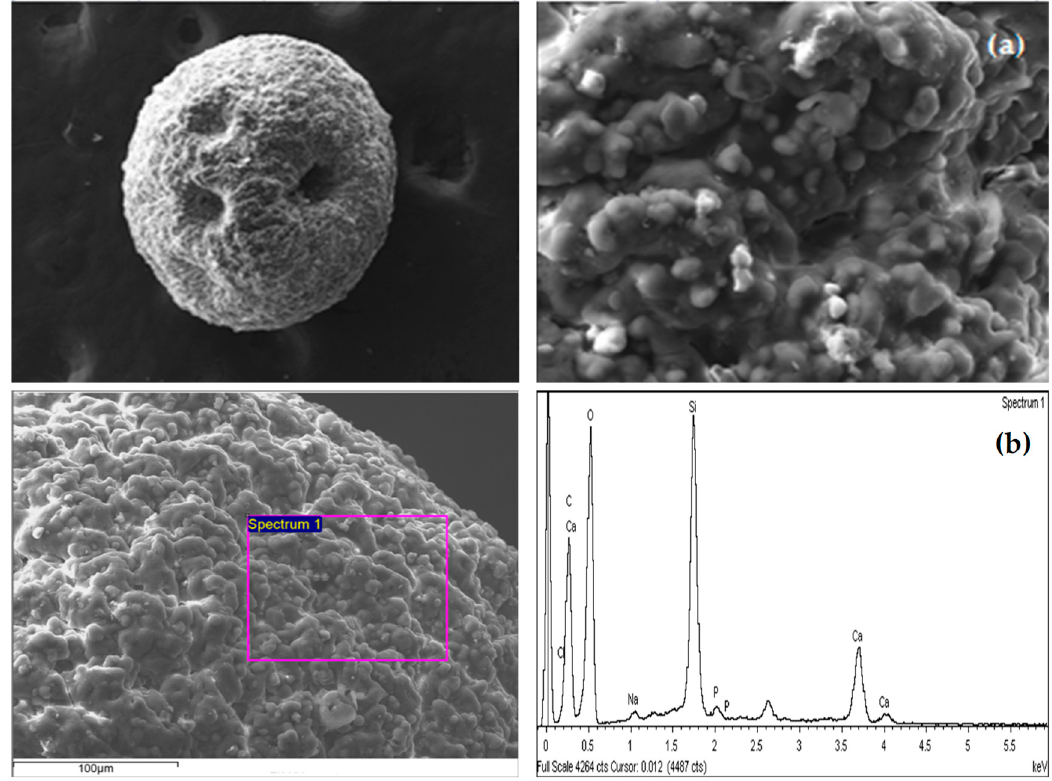
Figure 2. Scanning Electron Microscopy (SEM) images of the CAM-D2EHPA material: ( a ) Topography of the sorbent; ( b ) Energy Dispersive X-ray (EDX) analysis on the surface area of the solid.